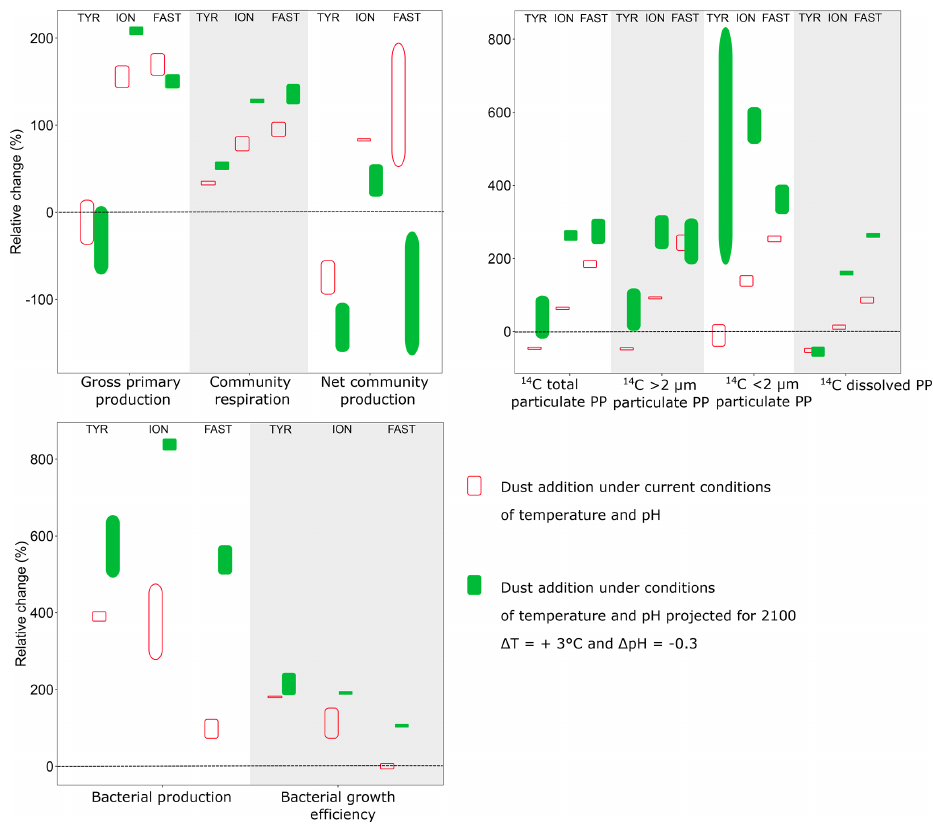
Figure 9. Relative difference (%) between integrated rates measured in tanks D (D1, D2; dust addition under present conditions of tempera- ture and pH) and G (G1, G2; dust addition under future conditions of temperature and pH) as compared to the controls (C1, C2) during the three experiments (TYR, ION and FAST). Vertical boxes represent the range observed between the two replicates per